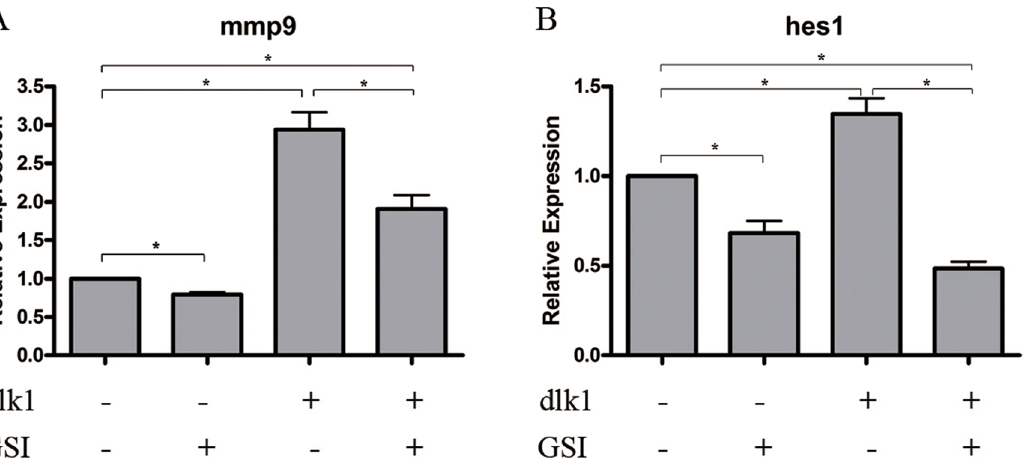
Figure 4. Effects of Notch signaling blockade on DLK1 -regulated MMP9 expression in the human lung cancer cell line H520. A, a bar graph of the mRNA expression of MMP9 detected by real-time PCR in H520 cells with or without DLK1 overexpression and with or without GSI treatment. The group with neither DLK1 stimulation nor GSI treatment (dlk 2 /GSI 2 ) was used as a control, and the expression level of MMP9 was set to 1. 18S ribosomal RNA was used as an internal control. B, the expression of HES1 evaluated by real-time PCR in parallel to MMP9 expression is shown in a bar graph, indicating Notch signaling activities upon DLK1 overexpression or GSI treatment. The experiments were performed in triplicate (* t-test, p-value ,